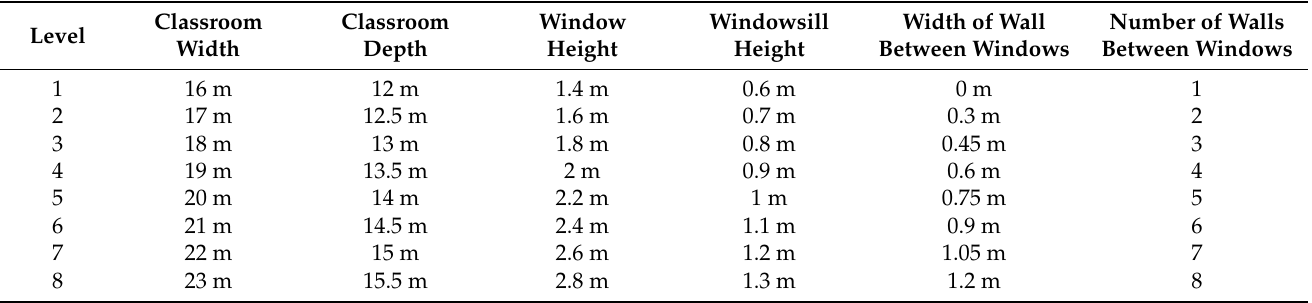
Table 1. Design factors and levels of terrace